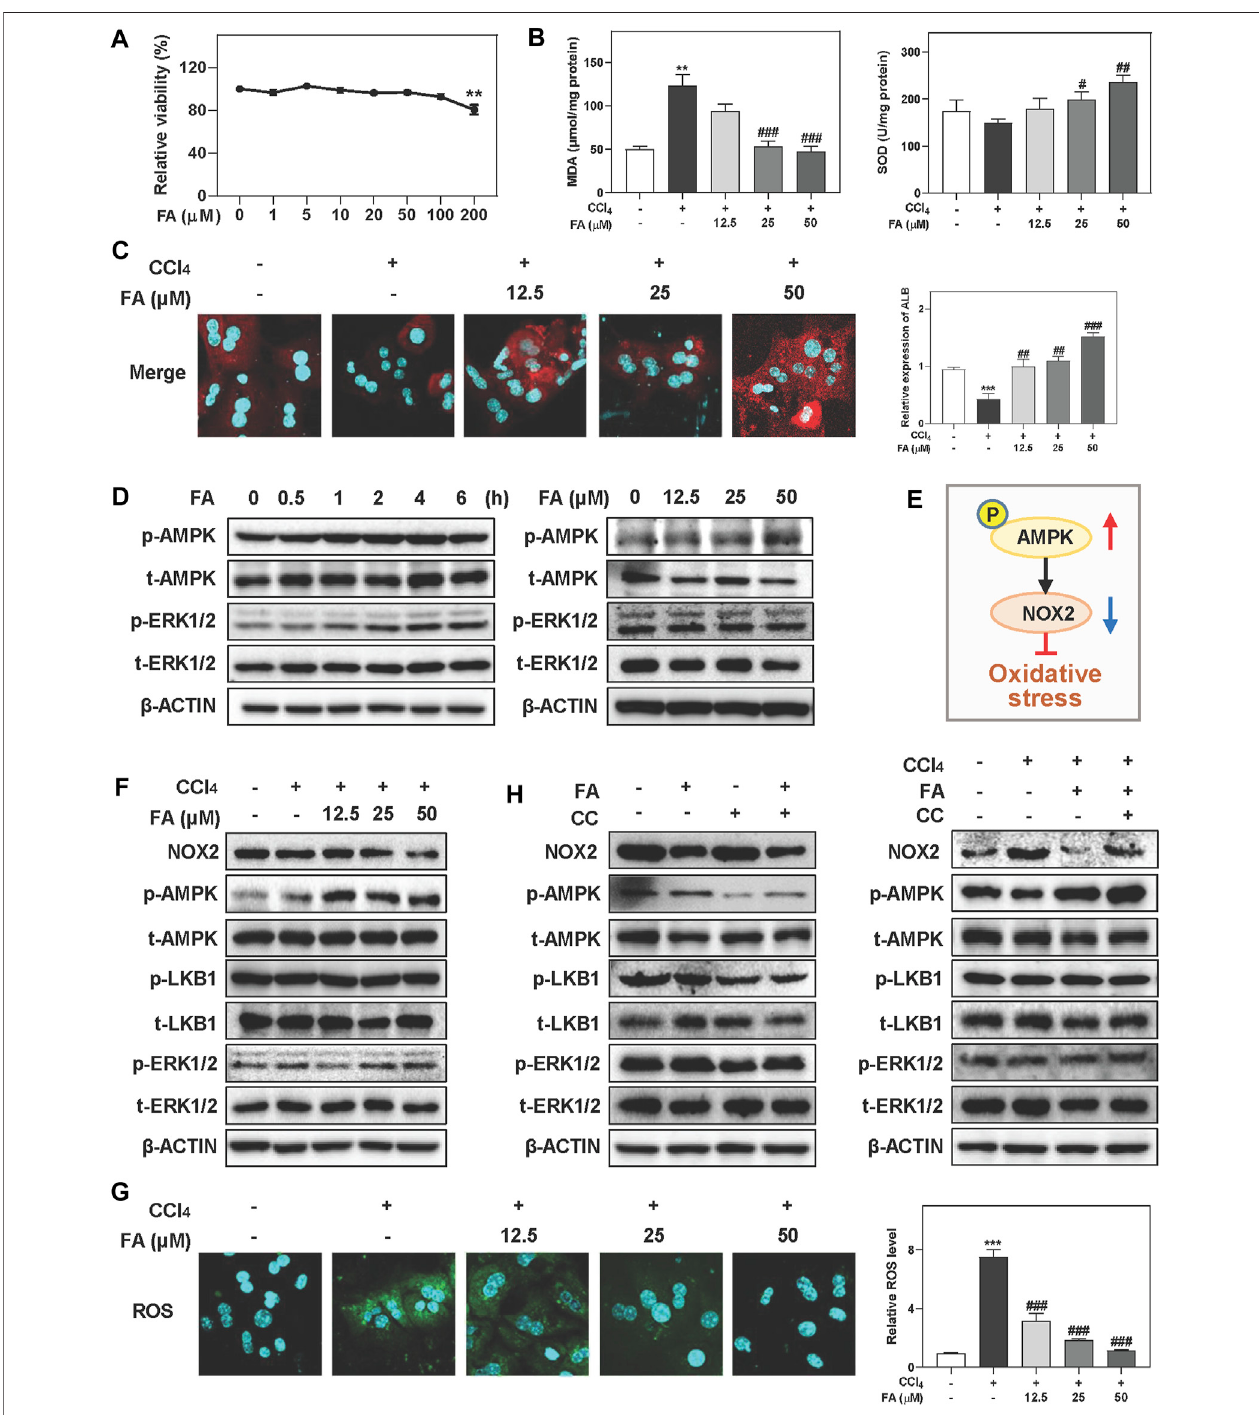
FIGURE2| FAimprovesCCl4-inducedoxidativestressandhepaticinjuryinMPHs. (A) ACCK-8assay. (B,C,FandG) MPHswerepre-treatedwithFAatdifferent concentrations for1 hand then treated withCCl 4 (10 mM)for another 24 h (B) MDA and SODlevelsin MPHs. (C) Representative images ofimmuno fl uorescent staining ofALBinMPHs. (D) MPHsweretreatedwith25 μ MFAatdifferenttimepointsordifferentconcentrationsofFAfor24 h. (E) Thepathway ofAMPKandNOX2involvedin oxidative stress. (G) Representative images of ROS immuno fl uorescent staining in MPHs. (H) After pre-treated with CC (2 μ M) or FA (25 μ M) or both, MPHs were administrated with CCl 4 (10 mM) for another 2 h or 24 h (D, F and H) Representative immunoblots against p-AMPK, t-AMPK, p-LKB1, t-LKB1, p-ERK1/2, t-ERK1/2, NOX2and β -ACTINwereshown.Statisticalsigni fi cance:** p < 0.01,*** p < 0.001,comparedwithcontrolgroup; # p < 0.05, ## p < 0.01, ### p < 0.001,comparedwithCCl 4 group. One-way ANOVA with Tukey ’ s post-hoc tests ( n (cid:1) 3).